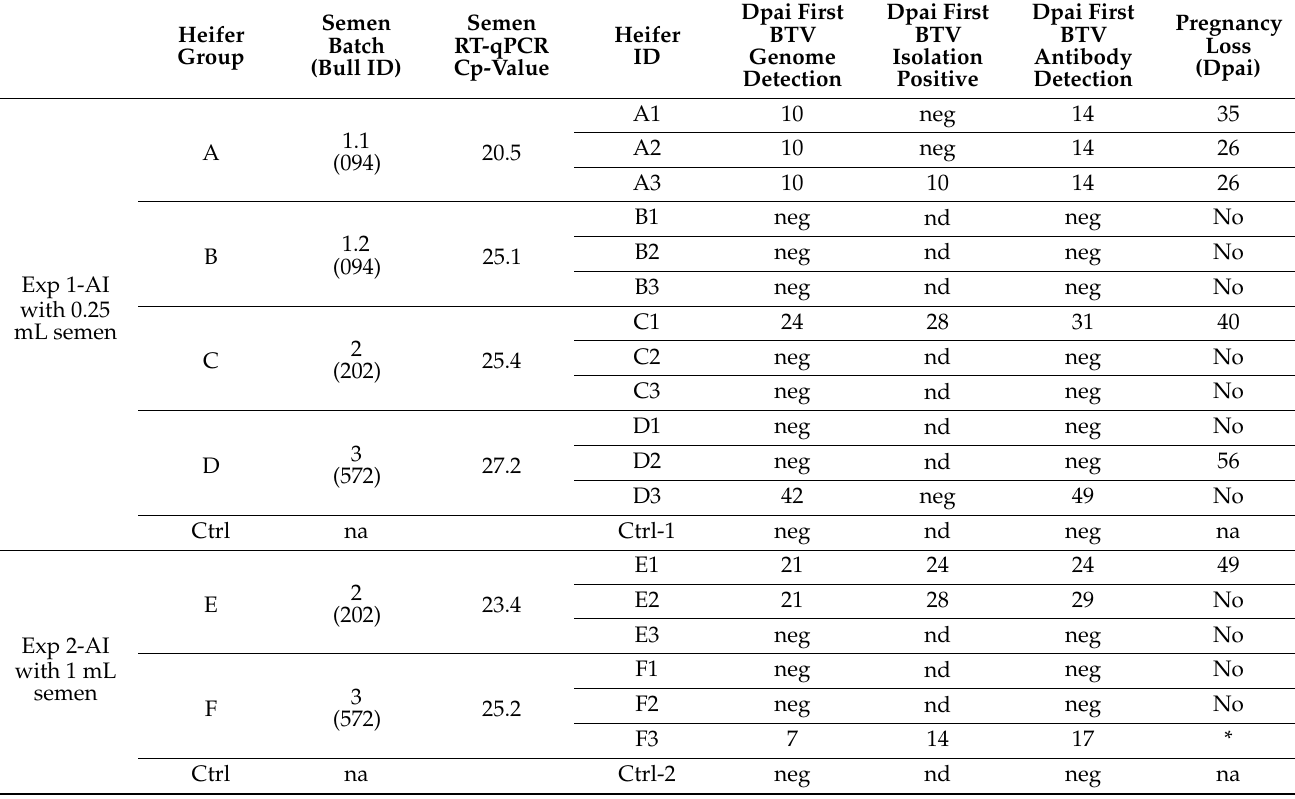
Table 1. Artificial insemination of heifers with bluetongue virus serotype 8 (BTV-8) contaminated semen. Overview of (i) two independent experiments; (ii) heifer groups; (iii) the semen batches used; (iv) heifer ID; (v) days post artificial insemination (dpai), at which the heifers became BTV real-time RT-PCR positive; (vi) dpai at which BTV was isolated; (vii) dpai at which the heifers became serological positive (competitive antibody-ELISA); and (viii) time points in dpai of pregnancy loss estimated using PAG and ultrasound results.